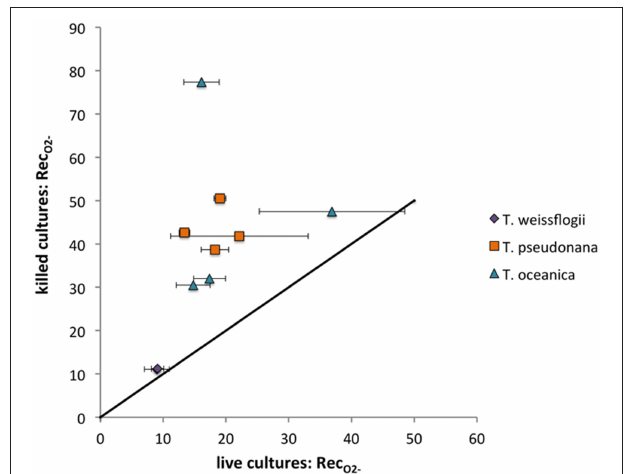
FIGURE 5 | O − 2 recoveries (%) for Thalassiosira cultures examined. Live values shown are averages and standard deviations from duplicate measurements on the same day. The line represents a 1:1 relationship.